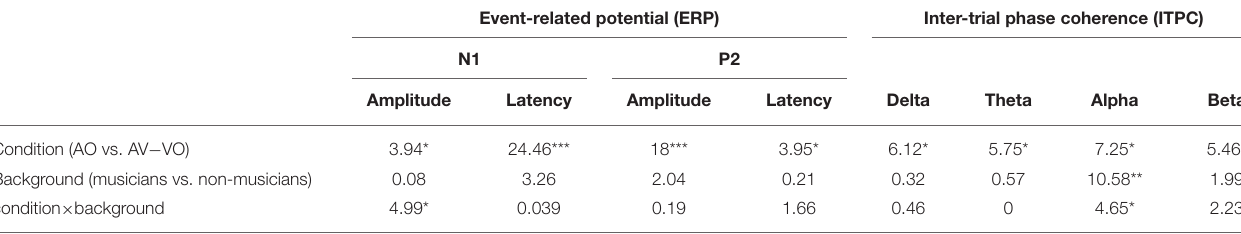
TABLE 4 | Summary of F-statistics of main effects and